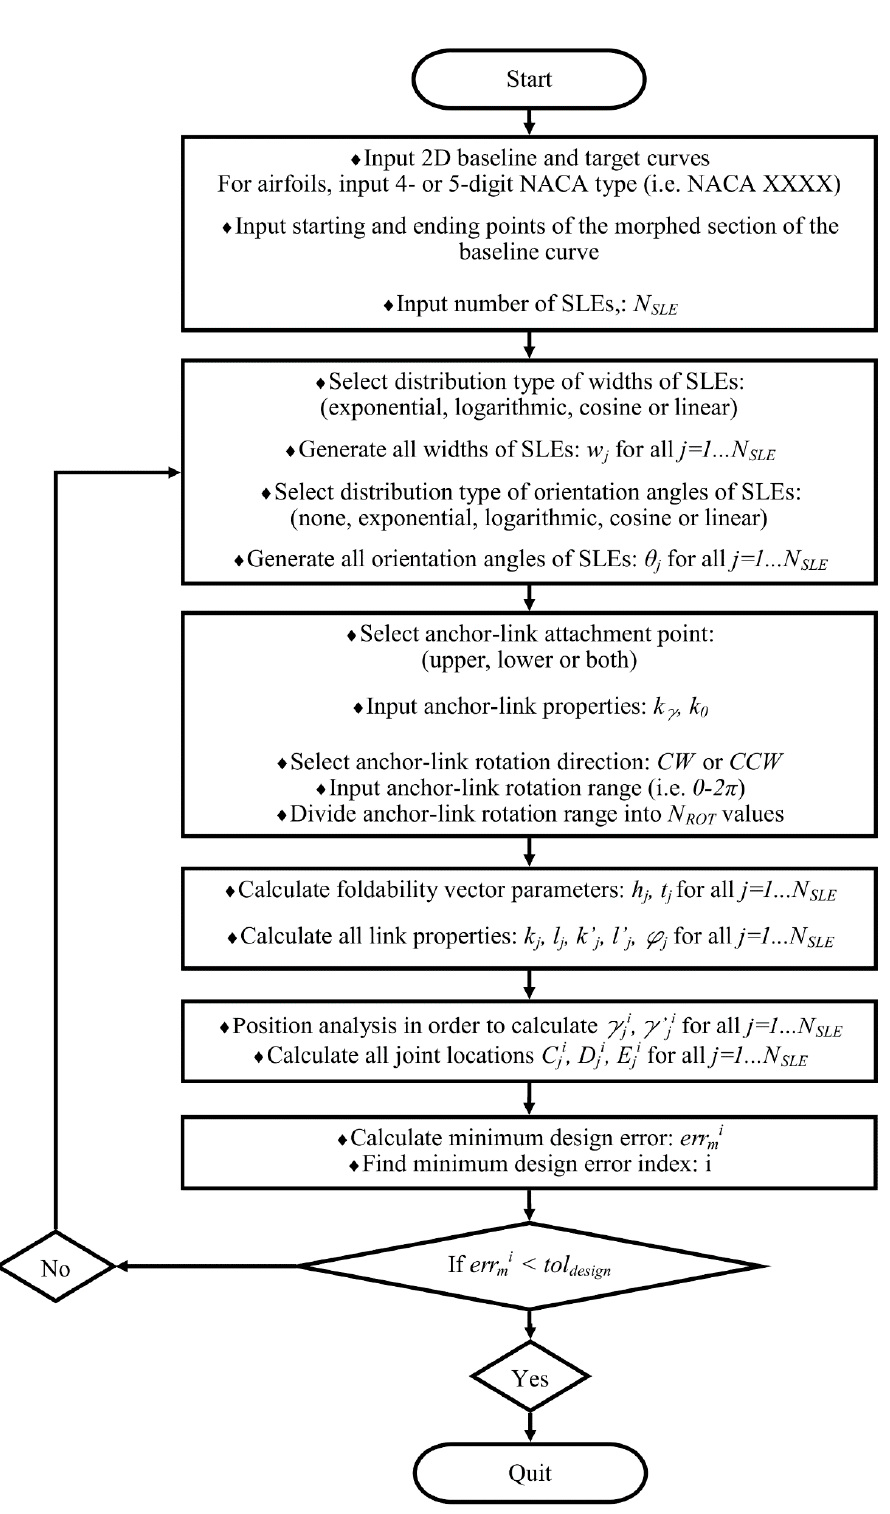
Figure A1. Flowchart of the computer routine developed, which synthesizes the SSM for given baseline and target curves.